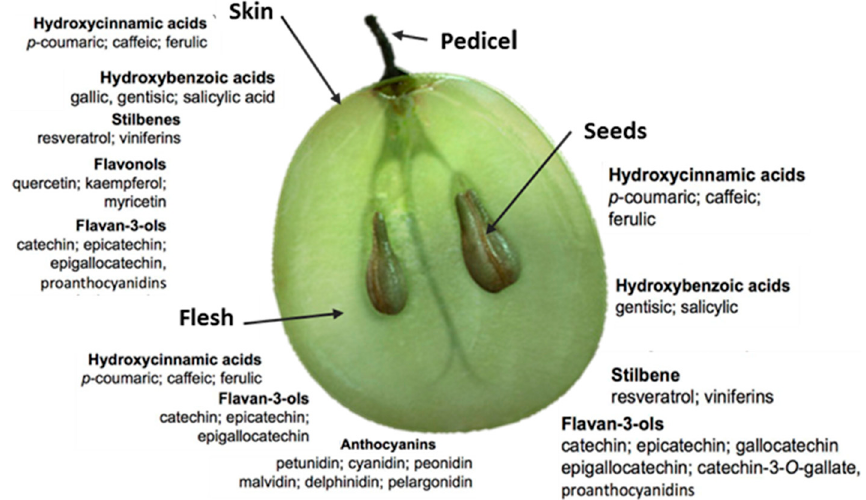
Figure 2. Schematic structure of a ripe grape berry and phenolic pattern biosynthesis distribution between several organs and tissues (indicated by arrows).